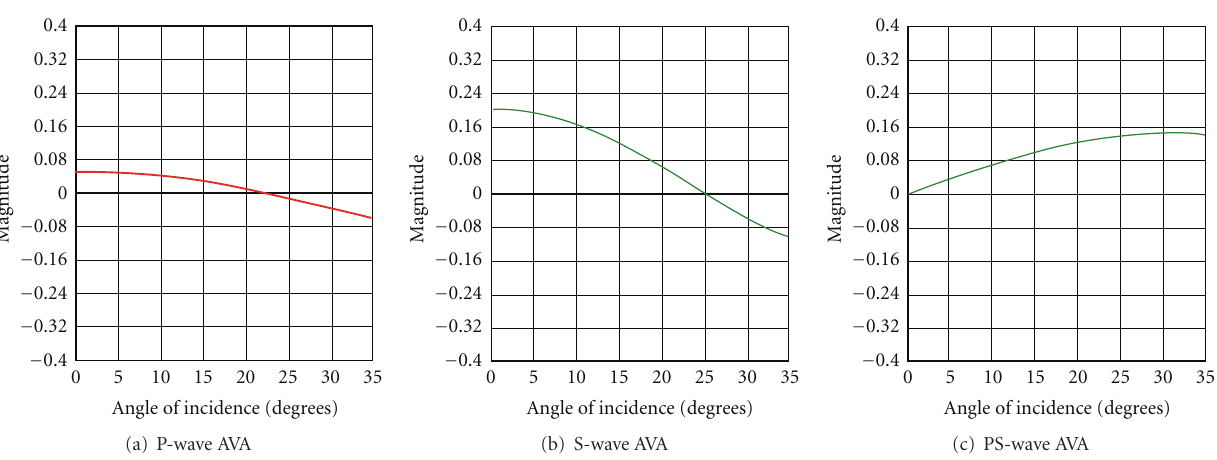
Figure 4: Amplitude versus angle (AVA) response for P-wave, S-wave, and PS-wave for the velocity contrast between Morrow shale and A sandstone shown in Figure 3.